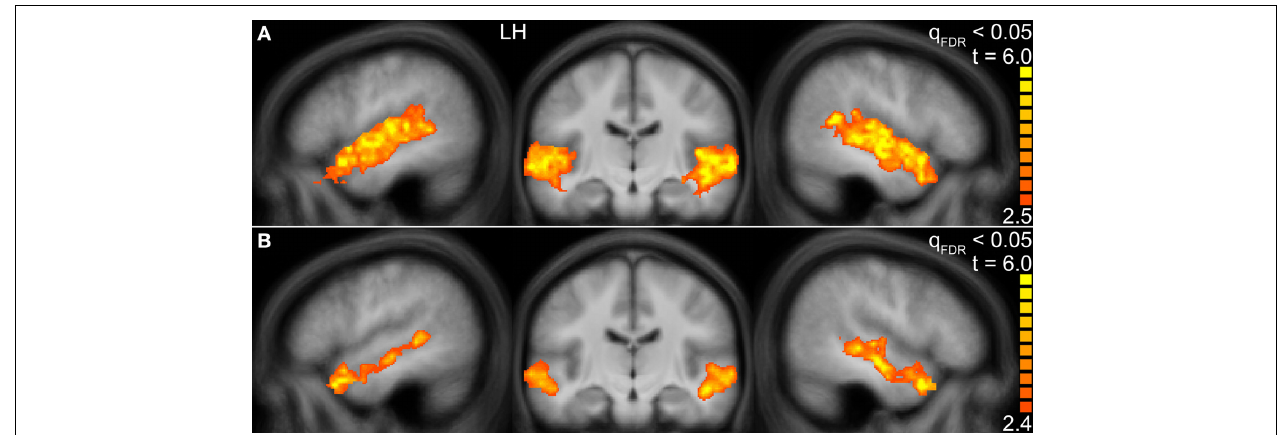
instruments (conjunction of H + and 2 H > A + M ). The sagittal views are shown in Talairach space at x = − 49 (LH, left hemisphere) and x = 47 (right hemisphere), the coronal views at y = −